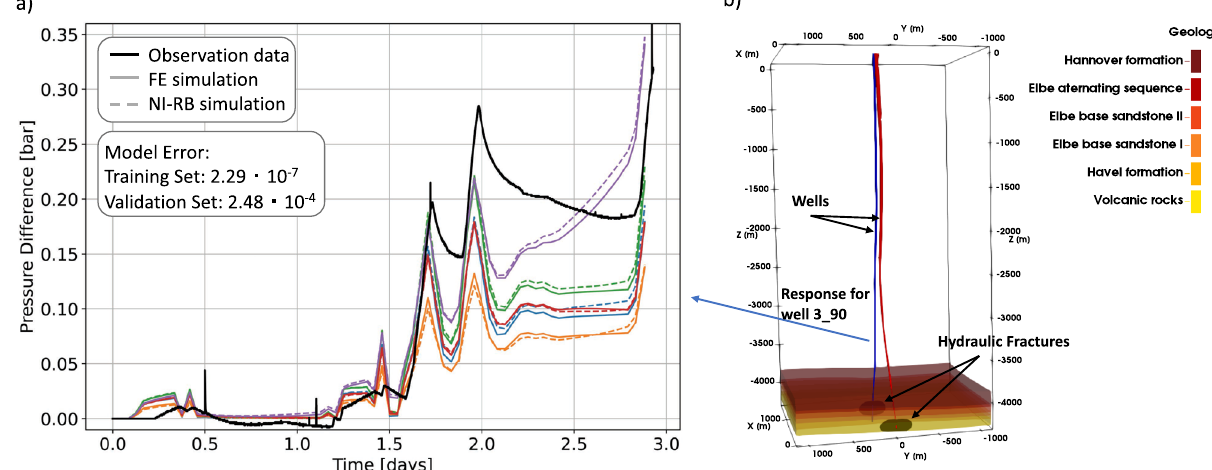
Figure 1. ( a ) Representation of the accuracy of the surrogate model of Groß Schönebeck for five different parameter realizations of the validation data set. The solid black line denotes the observation data, the colored solid lines the FE solutions and the dashed lines the RB solutions. ( b ) Overview of the geological reservoir model of Groß Schönebeck. Next to the six geological units also the two wells and the hydraulic fractures are